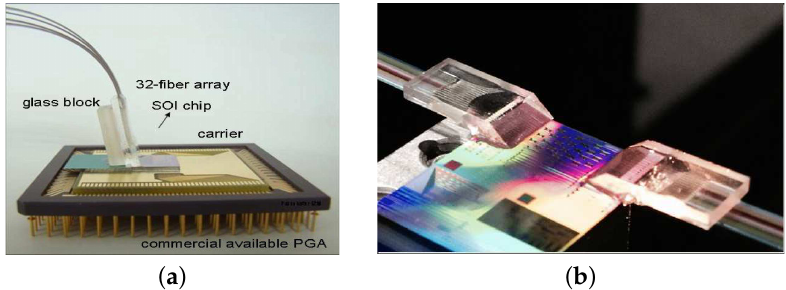
Figure 18. Two prominent fiber-chip packaging schemes. ( a ) Vertically mounted rigid fiber array coupling from g-pack, a packaging service offered by ePIXpack ( image reprinted with permission from [65]). ( b ) Multiarrayed fiber packaging with quasi-planar coupler at input and output ends of a photonic integrated circuit (Image courtesy of Tyndall National